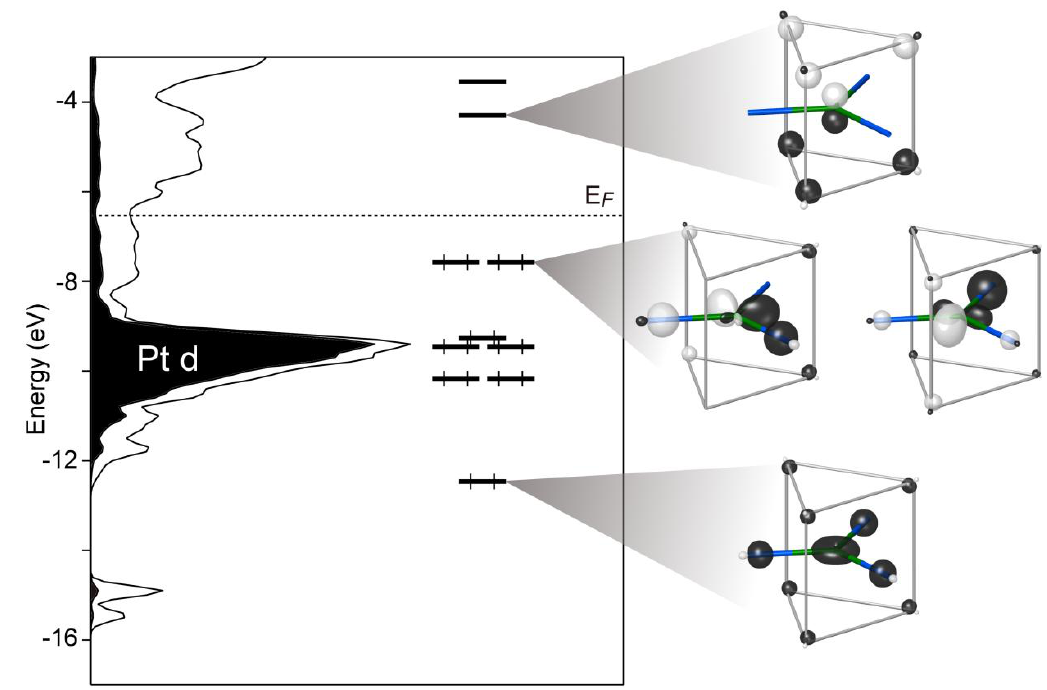
Figure 4. A molecular orbital (MO) interaction diagram showing the interaction of a Pt1 atom with σ-orbitals on its neighboring Ca and Si atoms. The DFT-calibrated Hückel DOS distribution is plotted alongside the MO diagram for